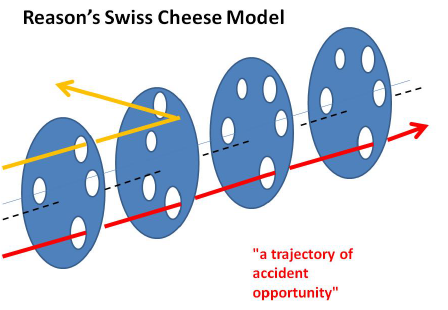
Fig. 2. The Swiss Cheese Model -